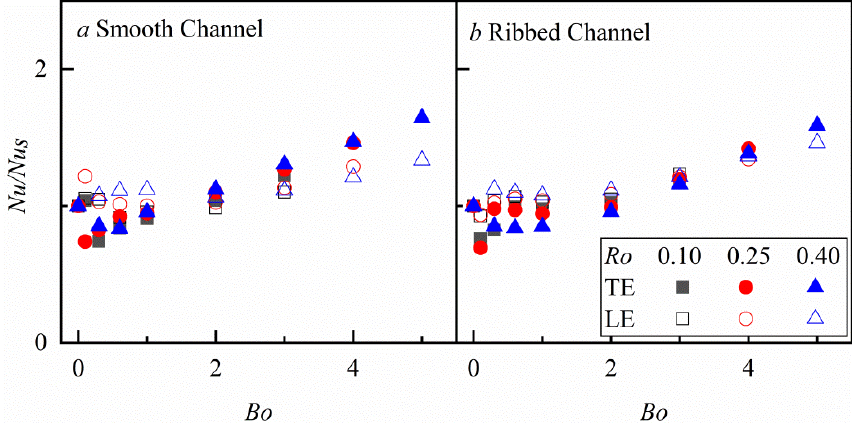
Figure 16. Nu / Nu s – Bo in the second passage (region 11).